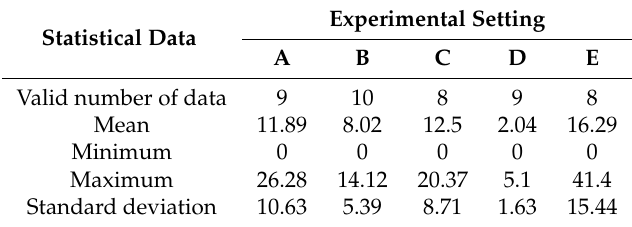
Table 3. Descriptive statistics for the experimental data presented in Table